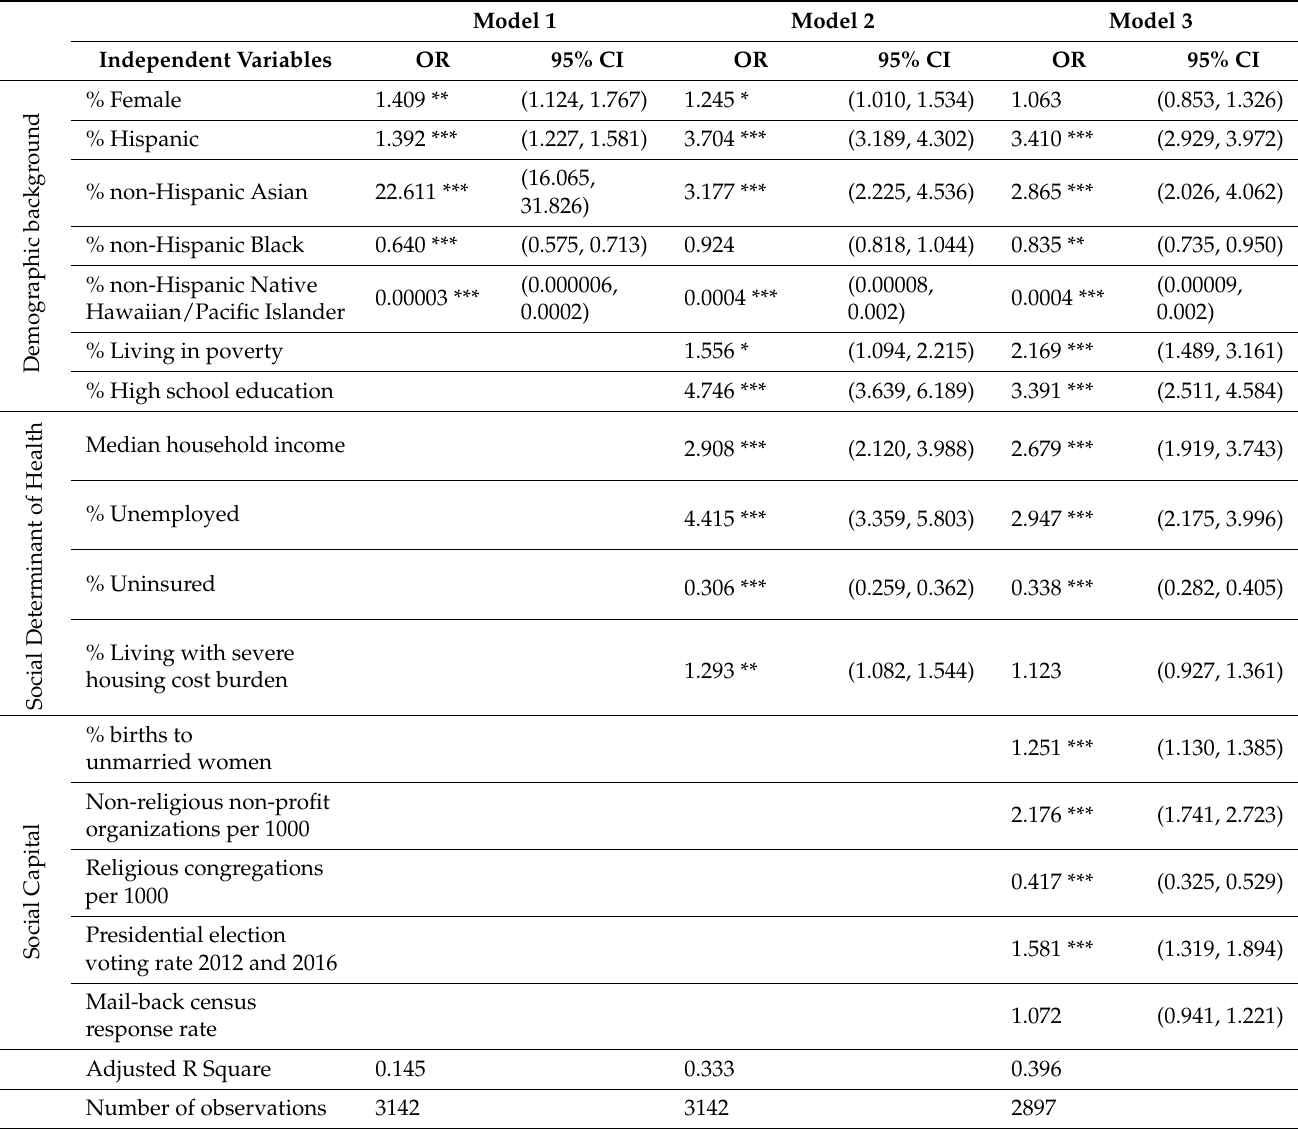
Table A3. Quasi-binominal regression results for Model 1, Model 2, and Model 3. Model